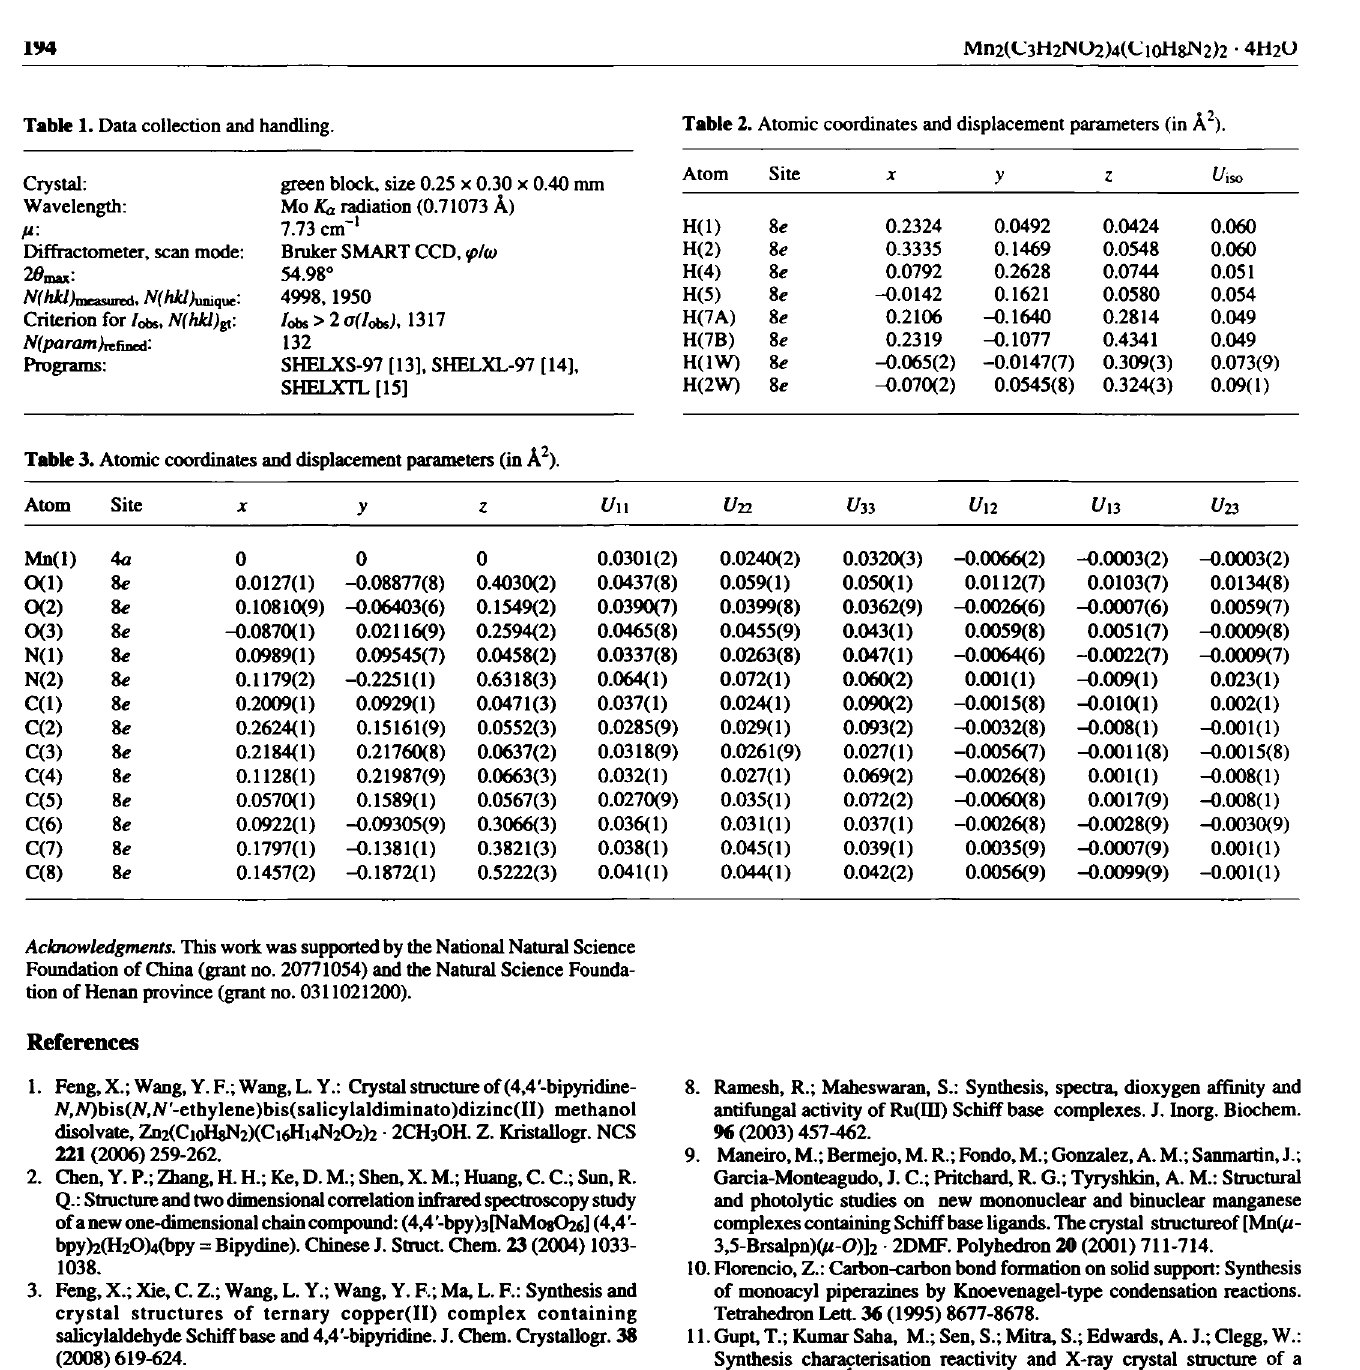
Table 1. Data collection and handling. Table 2. Atomic coordinates and displacement parameters (in Â 2 ).